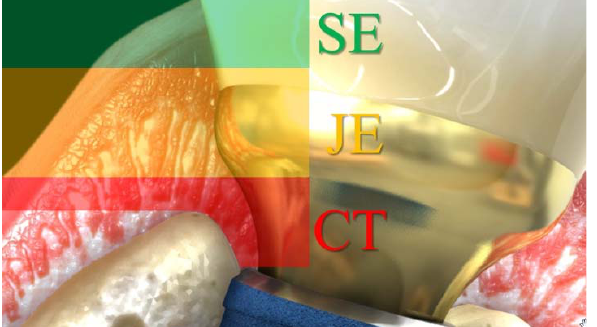
Figure 2. Sagittal section of the supracrestal soft tissues around implants and corresponding prosthetic components: connective tissues CT (red area), junctional epithelium JE (yellow area) and sulcular epithelium SE (green area), respectively.